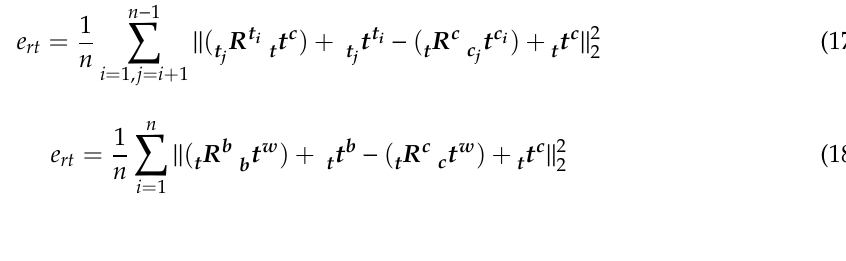
Figure 6. Probability distributions functions; ( a ) the measured position error from the robotic arm; ( b ) the modeled orientation error for the robotic arm.